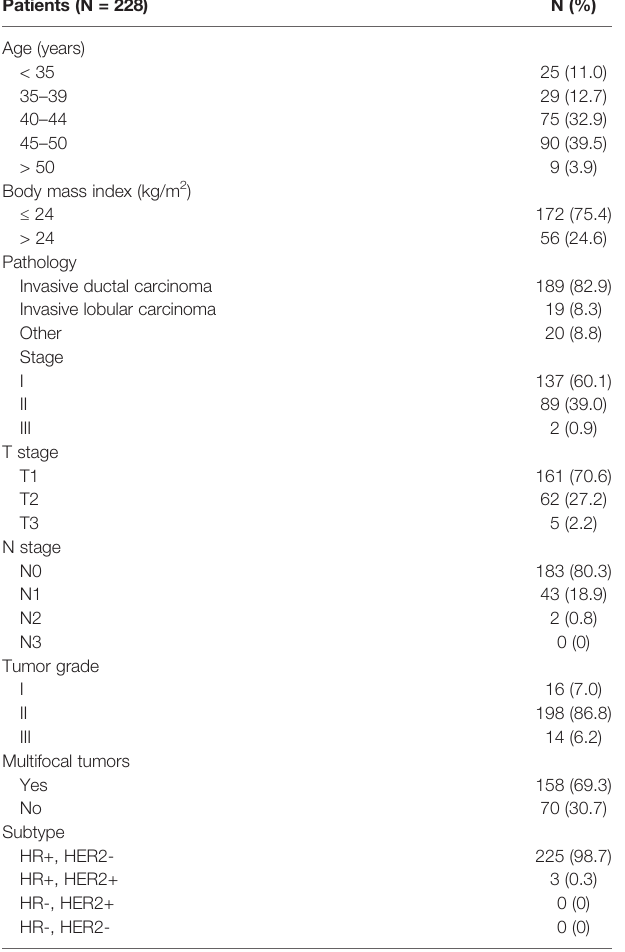
TABLE 3 | Changes in serum estradiol levels before and after administration of a 6-month luteinizing hormone-releasing hormone